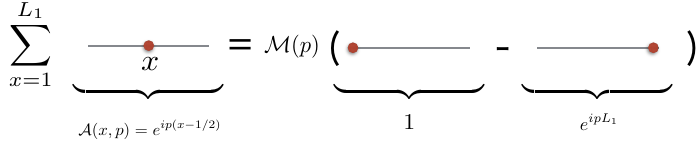
Figure 12 . Summation over the position as dynamical processes of